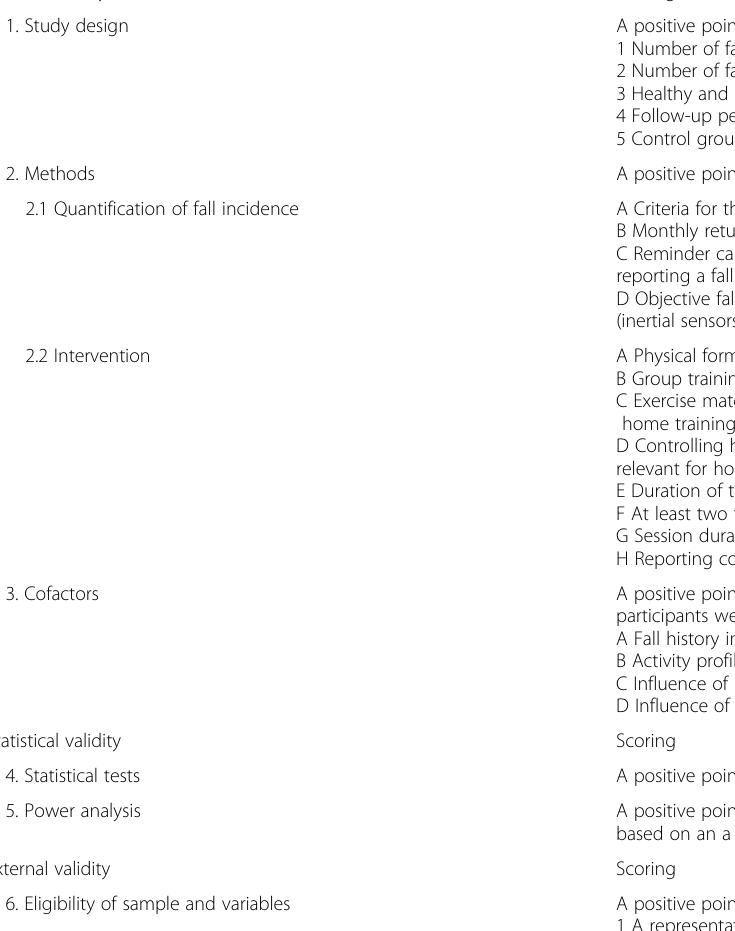
Table 1 Criteria of methodological quality Internal